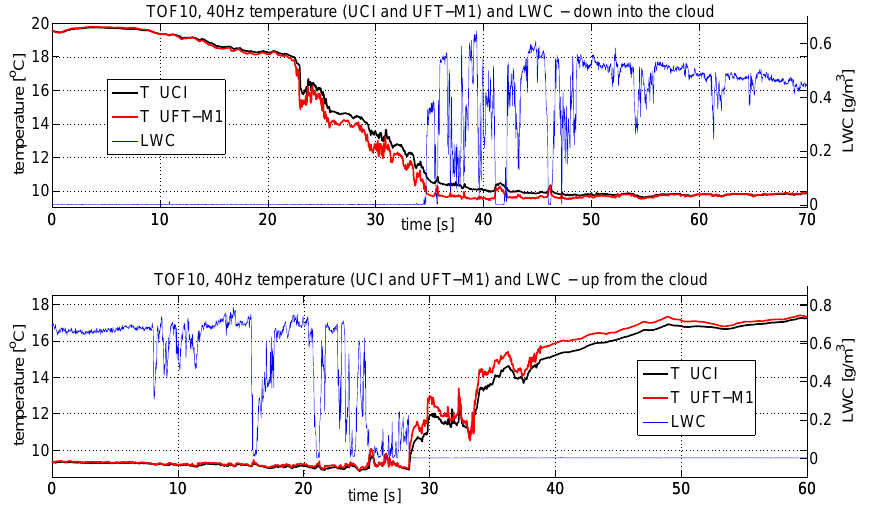
Fig. 6. Example UFT-M1 and UCI Rosemount 40Ss − 1 temperature records in the course of penetrations from cloud to free atmosphere (upper panel) and from free atmosphere to cloud (lower panel). The 40Ss − 1 LWC signal from PVM is added to show the